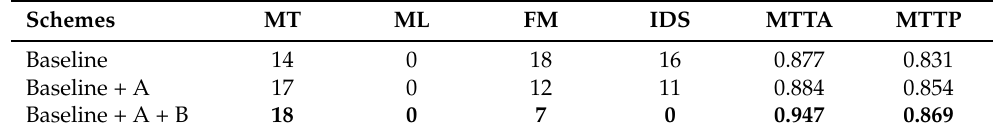
Table 8. Key component validation for multi-scale Faster-RCNN (denoted by A) and SiamNet (denoted by B) in the first test